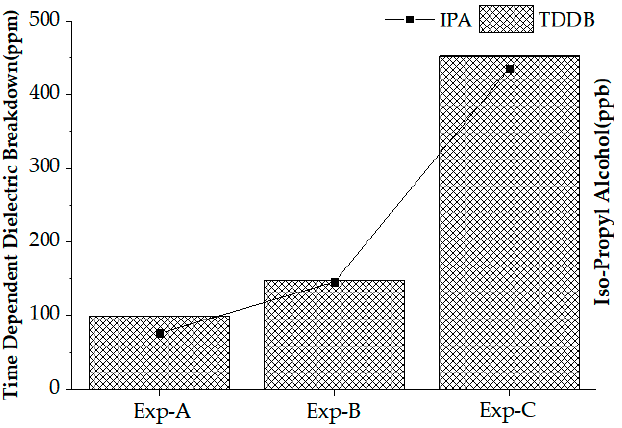
Figure 5. TDDB failure and IPA concentration.